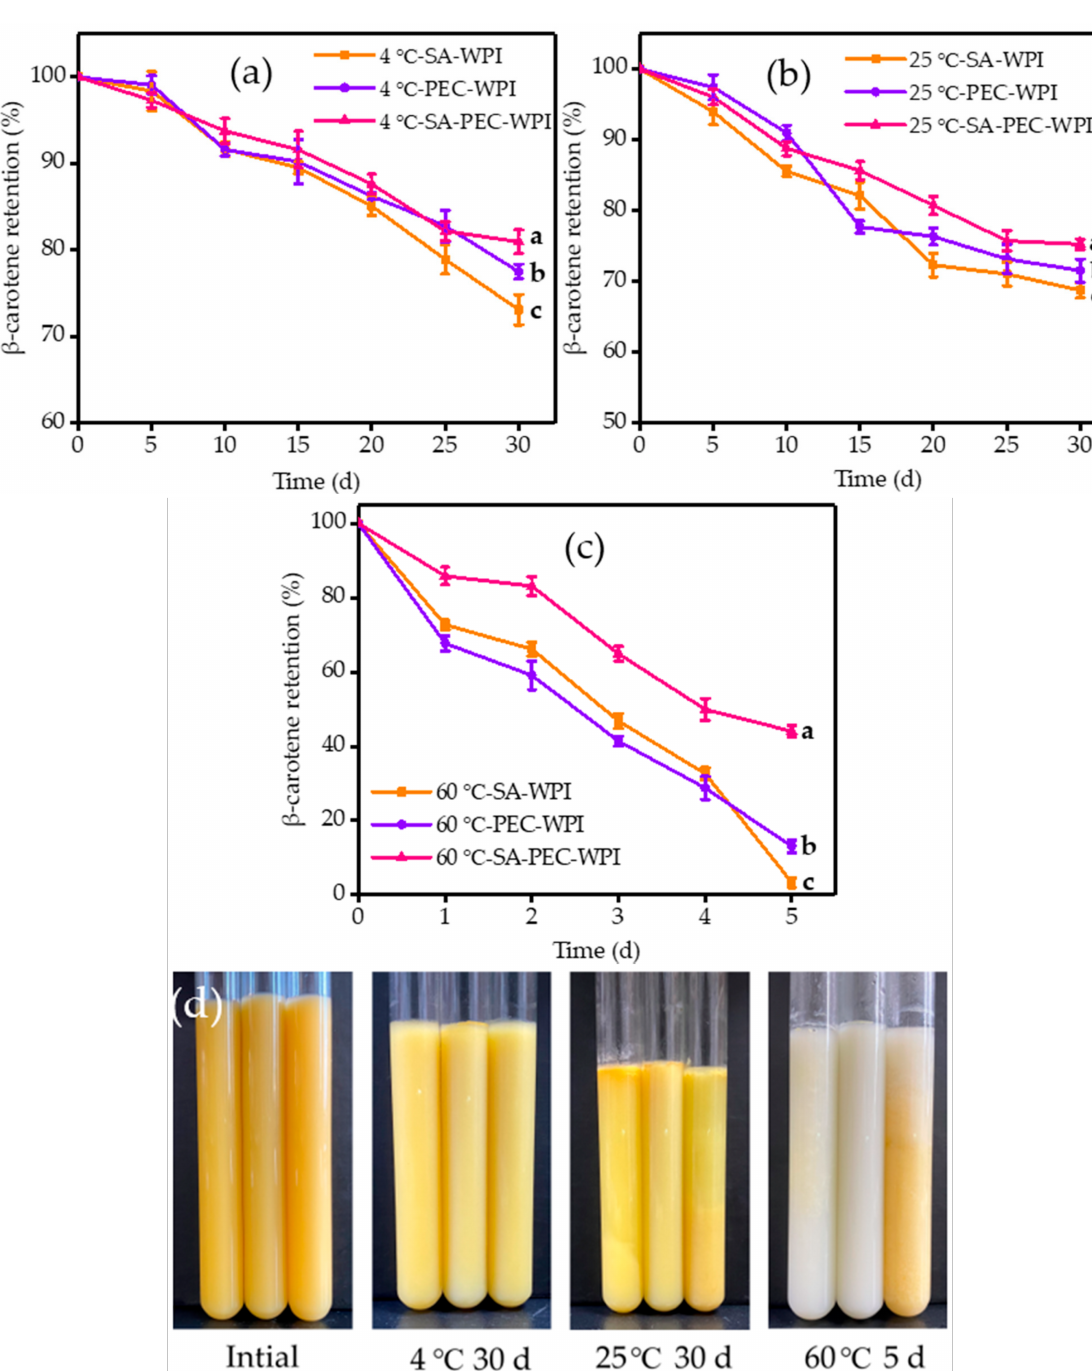
Figure 9. Degradation of β -carotene in the SA-WPI, PEC-WPI, and SA-PEC-WPI emulsions during storage at ( a ) 4 ◦ C for 30 d, ( b ) 25 ◦ C for 30 d, and ( c ) 60 ◦ C for 5 d. ( d ) The change in appearance of the emulsions before and after storage. The different letters (a–c) within the figure indicate significant differences ( p ≤ 0.05). SA: sodium alginate; PEC: pectin; WPI: whey protein